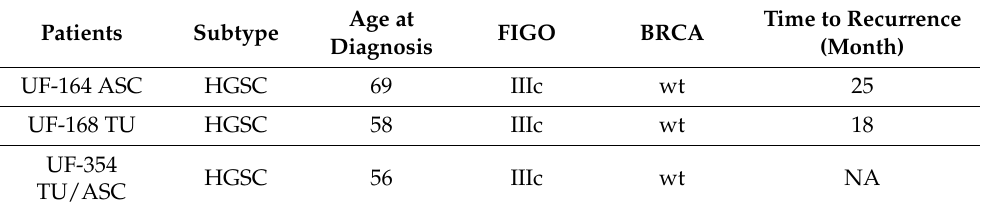
Table 1. Histopathological background and characteristics of patient material used for spheroid